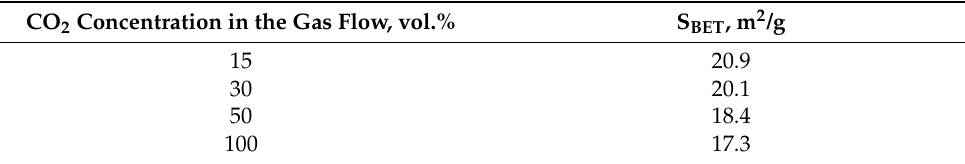
Table 2. The sorbent-specific surface area after the 25th carbonation–decarbonation cycle at different CO 2 concentrations in the gas flow during